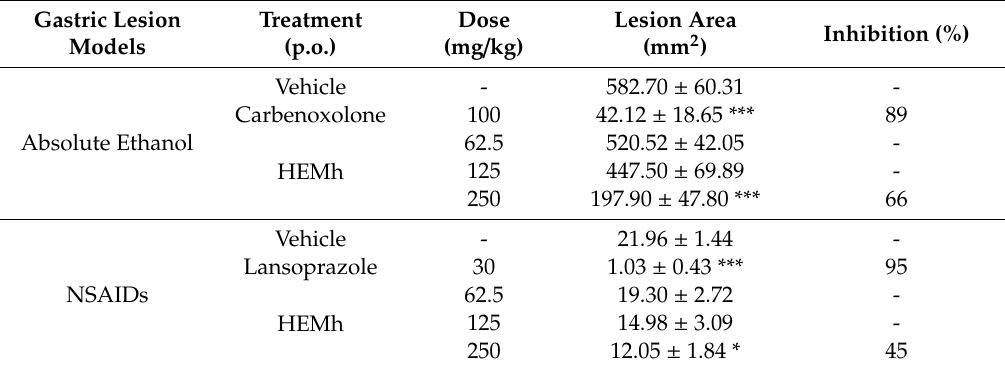
Table 6. E ff ects of hydroalcoholic extract from the twigs of Machaerium hirtum (HEMh) on acute gastric lesion induced by absolute ethanol or NSAIDs in rats. Gastric Lesion Treatment Models